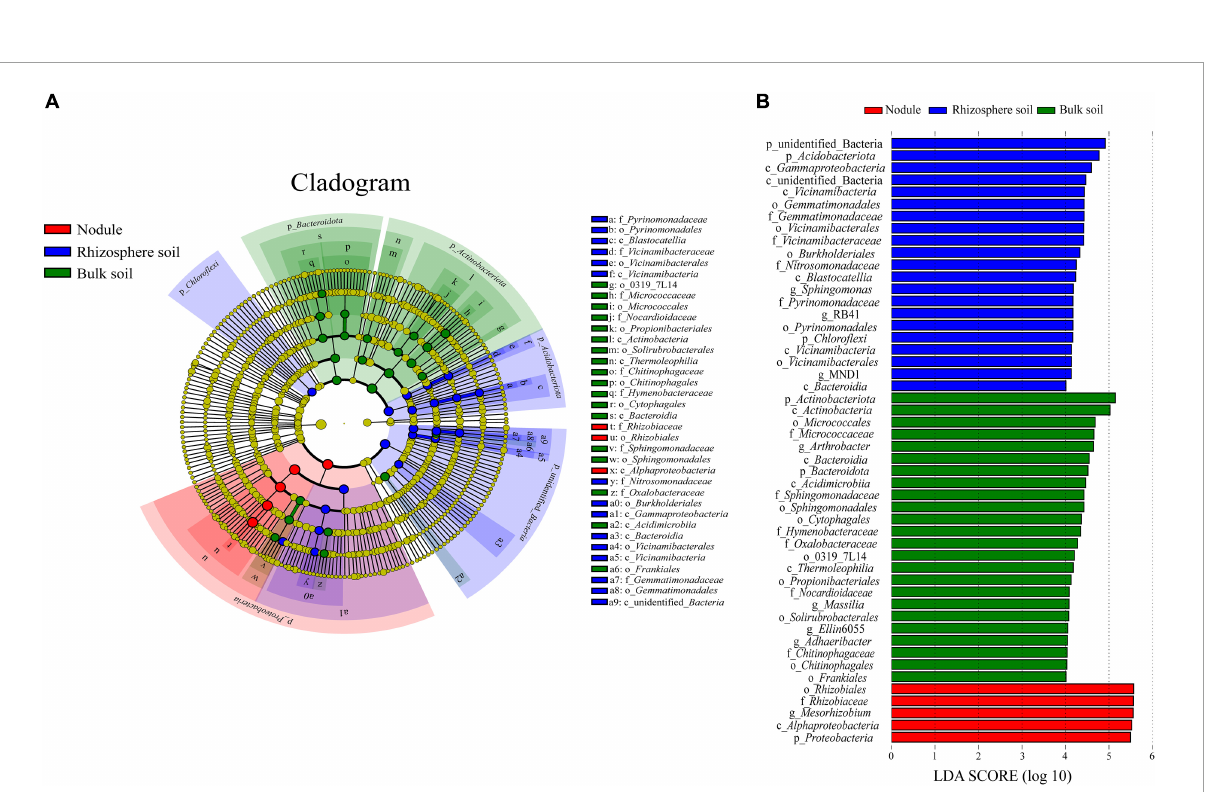
FIGURE7 Results of the LEfSe analysis. (A) is phylogenetic cladistic diagram of the LEfSe. The circle of radiation from the center to the periphery represents the level of classification from the phylum to the species. Each small circle at different classification levels represents a classification at that level, and the diameter of the small circle is proportional to the relative abundance. (B) is histogram of the LDA value distribution (LDA >